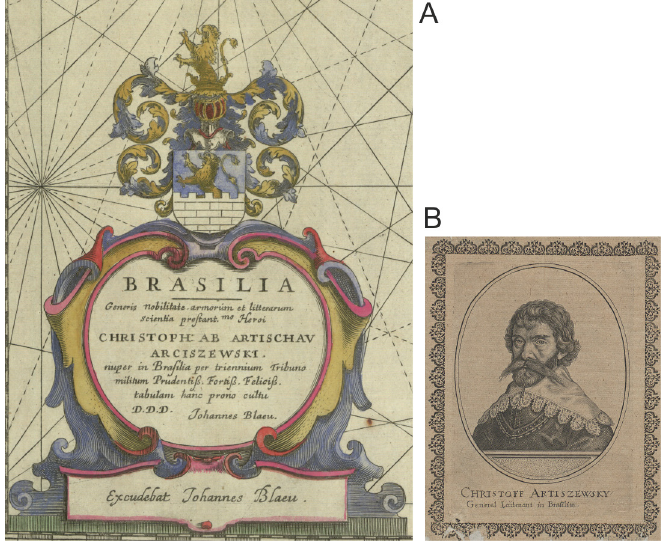
Fig. 9. Jan Blaeu, Brasilia (fragment) and a portrait of Krzysztof Arciszewski; National Library